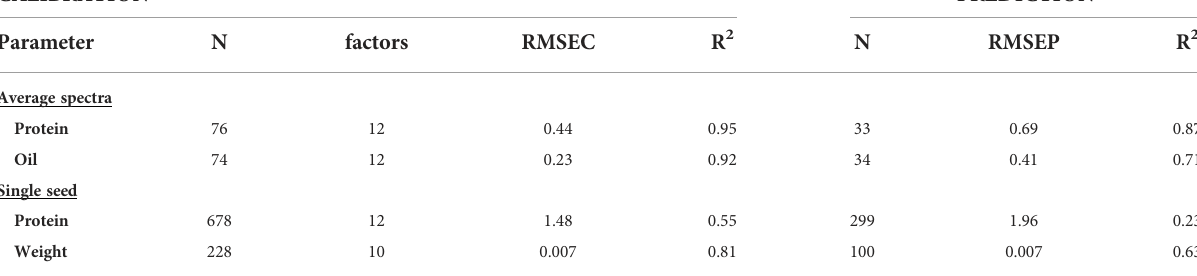
TABLE 4 Summary of calibration and prediction statistics for protein, oil, and weight models using mean and single seed spectra of sorghum. CALIBRATION PREDICTION